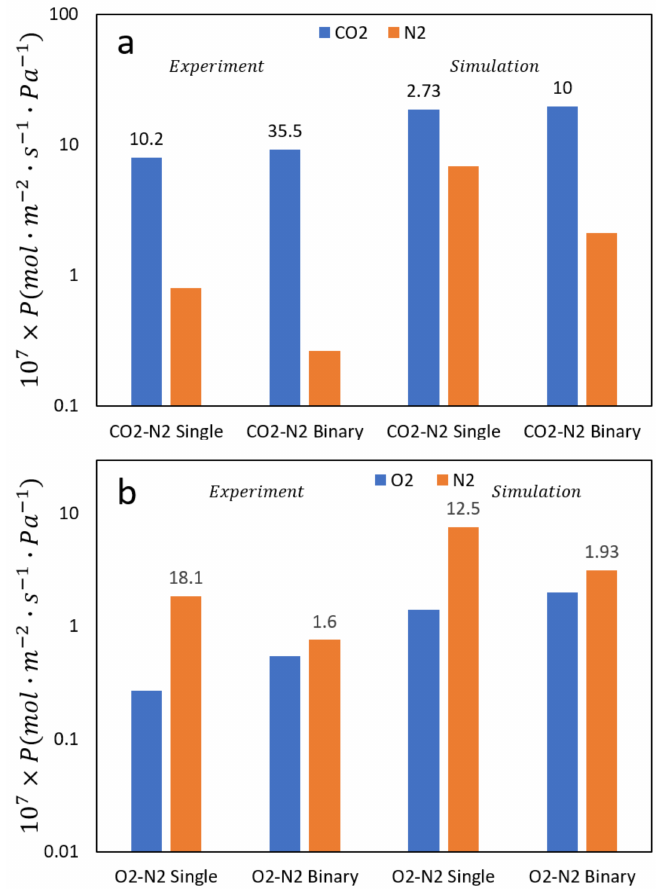
Figure 6. The permeance of ( a ) O 2 /N 2 and ( b ) CO 2 /N 2 for both pure systems and equimolar binary mixtures compared with experimental results. The first two sets are experimental results while the last two are simulation results as marked. The numbers above the permeances represent the separation factors (SF). Note the contrasting behavior between pure fluids and mixtures for the two systems that the simulation results correctly predict.